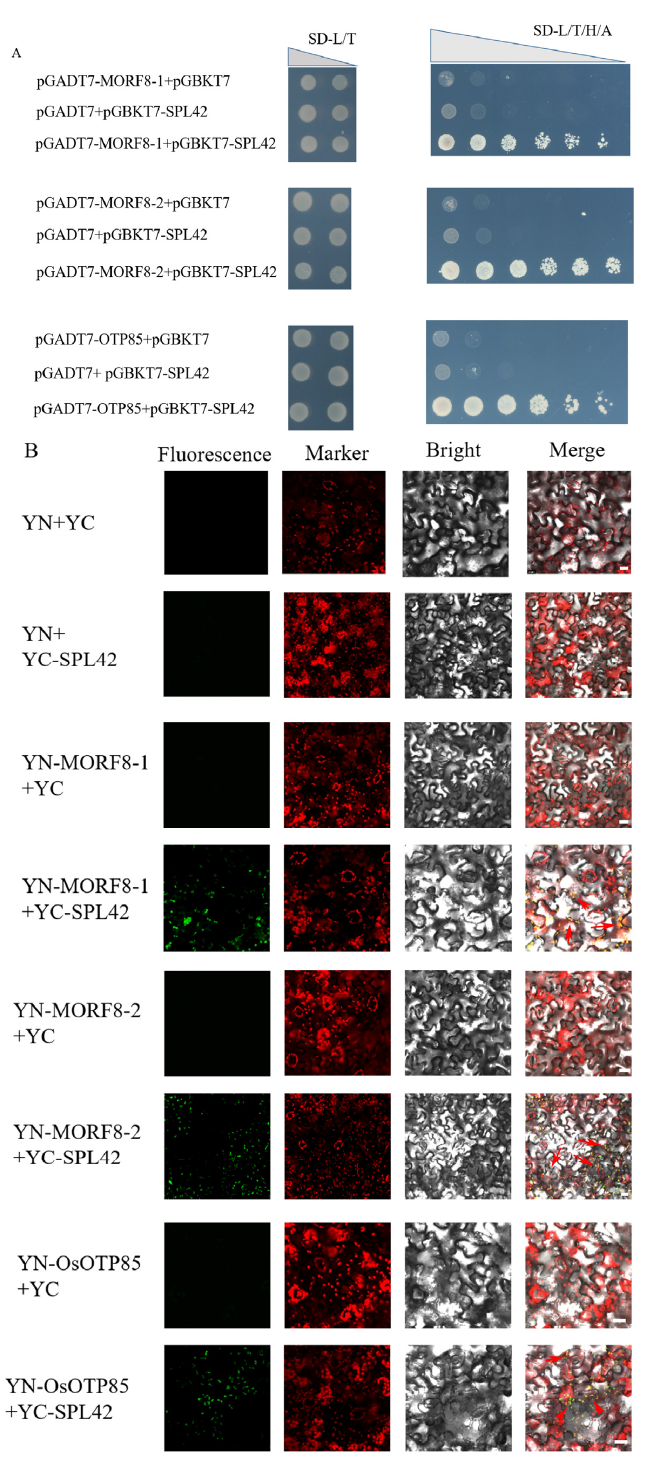
Figure 9. SPL42 physically interacts with OsMORF8-1 and OsMORF8-2. ( A ) SPL42 physically interacts with OsMORF8-1 and OsMORF8-2 in yeast. The indicated construct pairs were co-transformed into yeast strain AH109. Interactions between bait and prey were examined on control medium 2 (SD/- Leu/-Trp) and selective medium 4 (SD/-Leu/-Trp/-His/-Ade). AD: activation domain; BD: binding domain. ( B ) Bimolecular fluorescence complementation assay showing the interactions between SPL42 and OsMORF8-1 as well as OsMORF8-2 in tobacco leaf epidermal cells. Signals from GFP fluorescence, chlorophyll autofluorescence, bright field, and merged images are shown. The arrows indicate signal areas with a strong interaction. Scale Bar = 20 µ